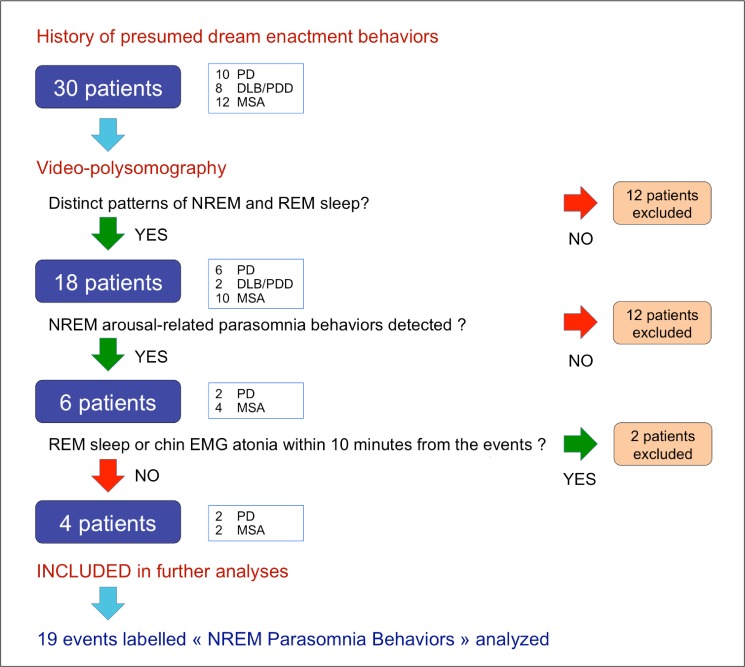
Flow chart explaining the selection procedure of the patients and on the NREM Parasomnia Behaviors (NPBs) on which subsequent analyses were conducted.